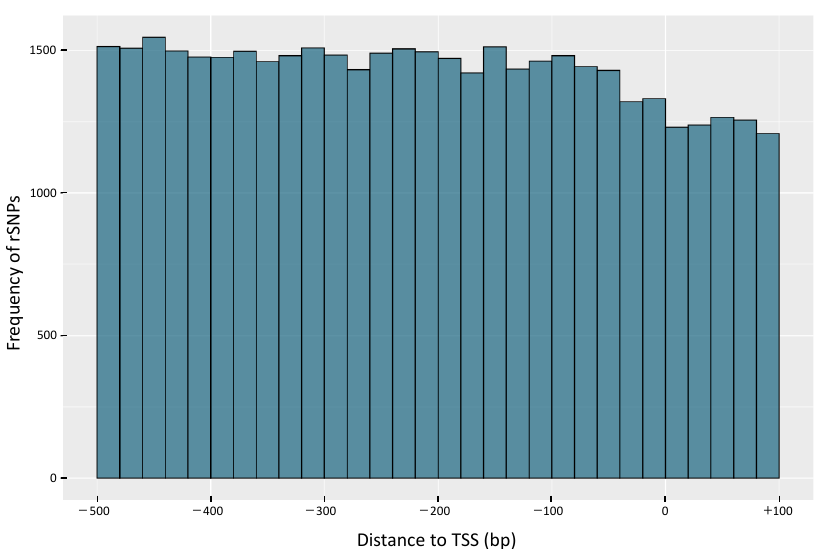
Figure 3. Distribution of rSNPs relative to the transcription start sites (TSS) of the corresponding genes. Position 0 denotes the position of the TSS.